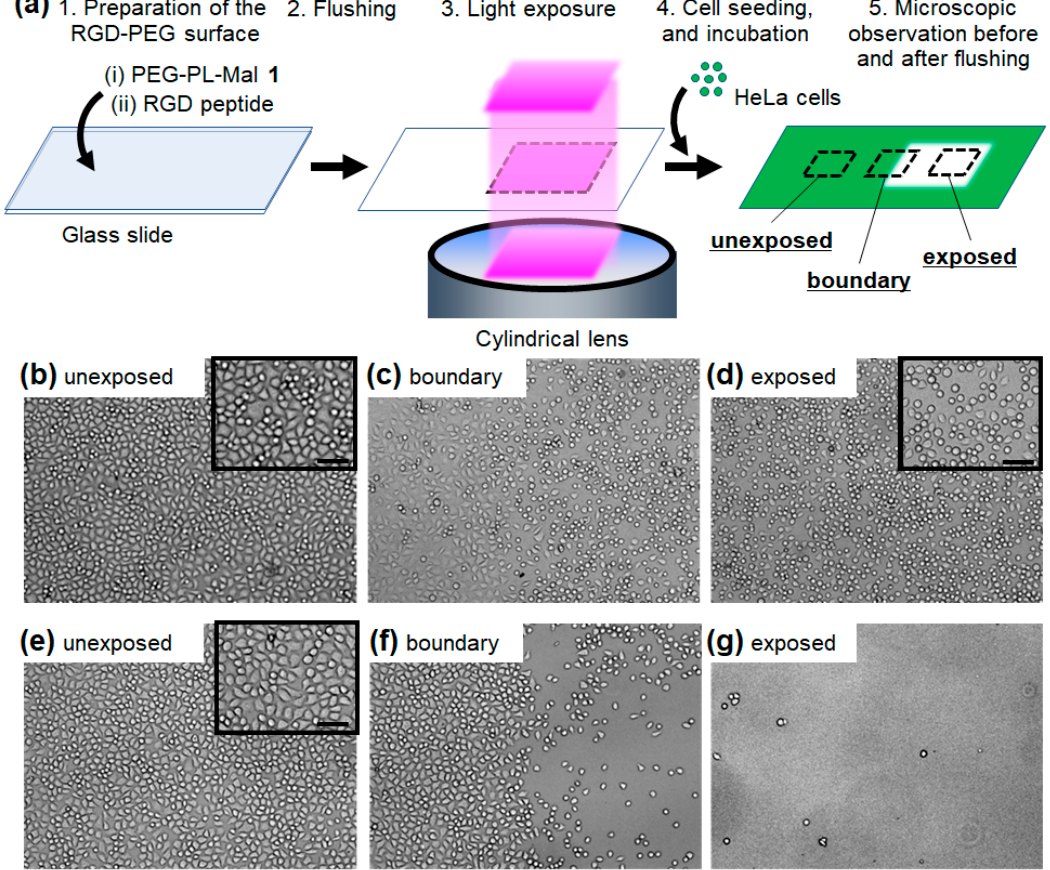
Figure 2. Cell adhesion on the photocleavable RGD-PEG surface exposed to light before cell seeding. ( a ) Schematic illustration of the photo-responsive cell attachment. HeLa cells on the surface were observed at the ( b , e ) unexposed region, ( c , f ) the boundary region between the unexposed ( left ) and exposed regions ( right ), and ( d , g ) the exposed region. The bright-field microscopic images were obtained ( b – d ) before and ( e – g ) after flushing the non-adhered cells from the surface. Light dose: 4.0 J/cm 2 . Scale bars: 200 μ m. ( inset ) Magnified images. Scale bars: 50 μ m.